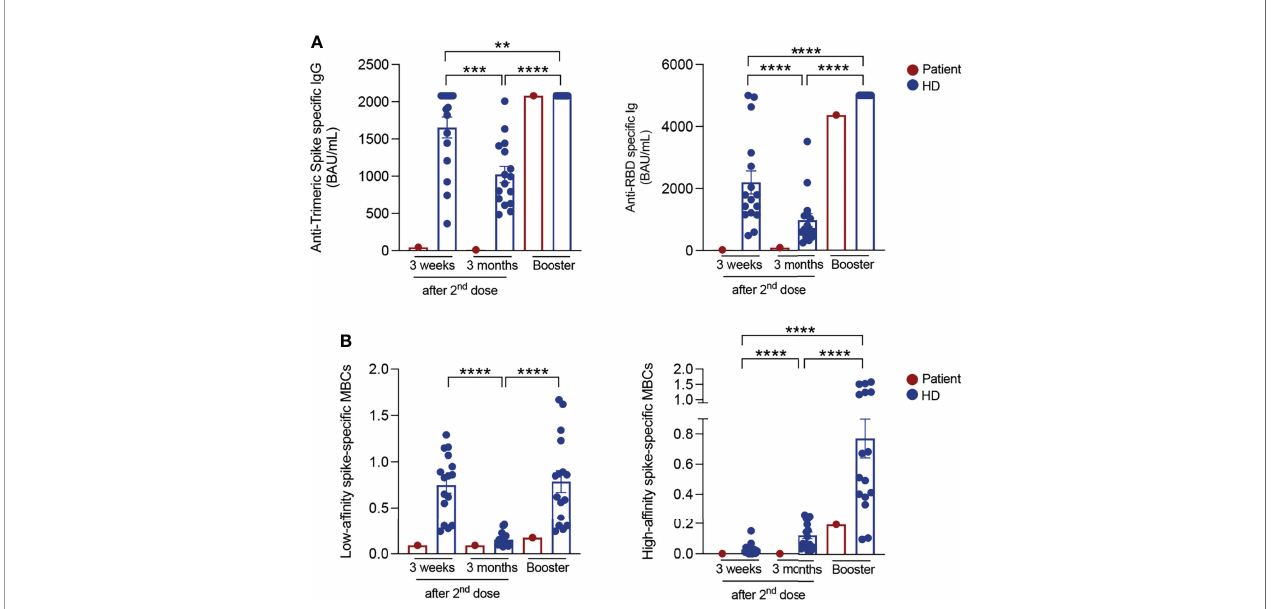
FIGURE 1 | SARS-CoV-2 antibody responses and speci fi c memory B cells. (A) Anti-Trimeric Spike speci fi c IgG, total anti-RBD antibody levels and (B) percentage of S+ (low-af fi nity) and S++ (high-af fi nity) MBCs measured at different time points in vaccinated HCWs (in blue; n=16 ) and in the patient (in red): 3 weeks and 3 months after the second dose and 10 days post-booster (BNT162b2 mRNA vaccine for control HCWs and Ad26.COV2.S COVID-19 vaccine for the patient). Column indicate mean and SEM. Statistical signi fi cance was determined using Wilcoxon matched pairs signed rank test. **p < 0.01, ***p < 0.001, ****p <